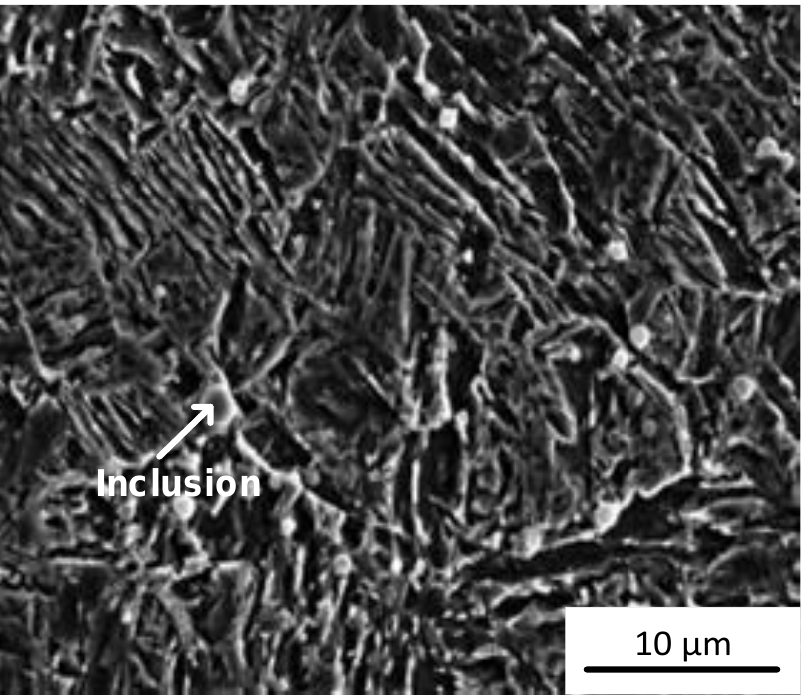
Figure 9. SEM image of rare earth inclusions pinning the austenite grain boundaries with the heat input 1.78 kJ/mm.